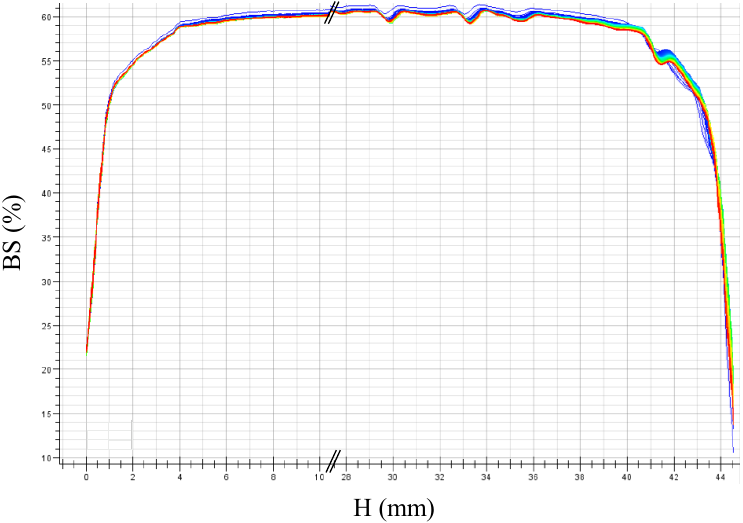
Figure 8. Turbiscan ® measurements of the HD-SBR#01 latex.